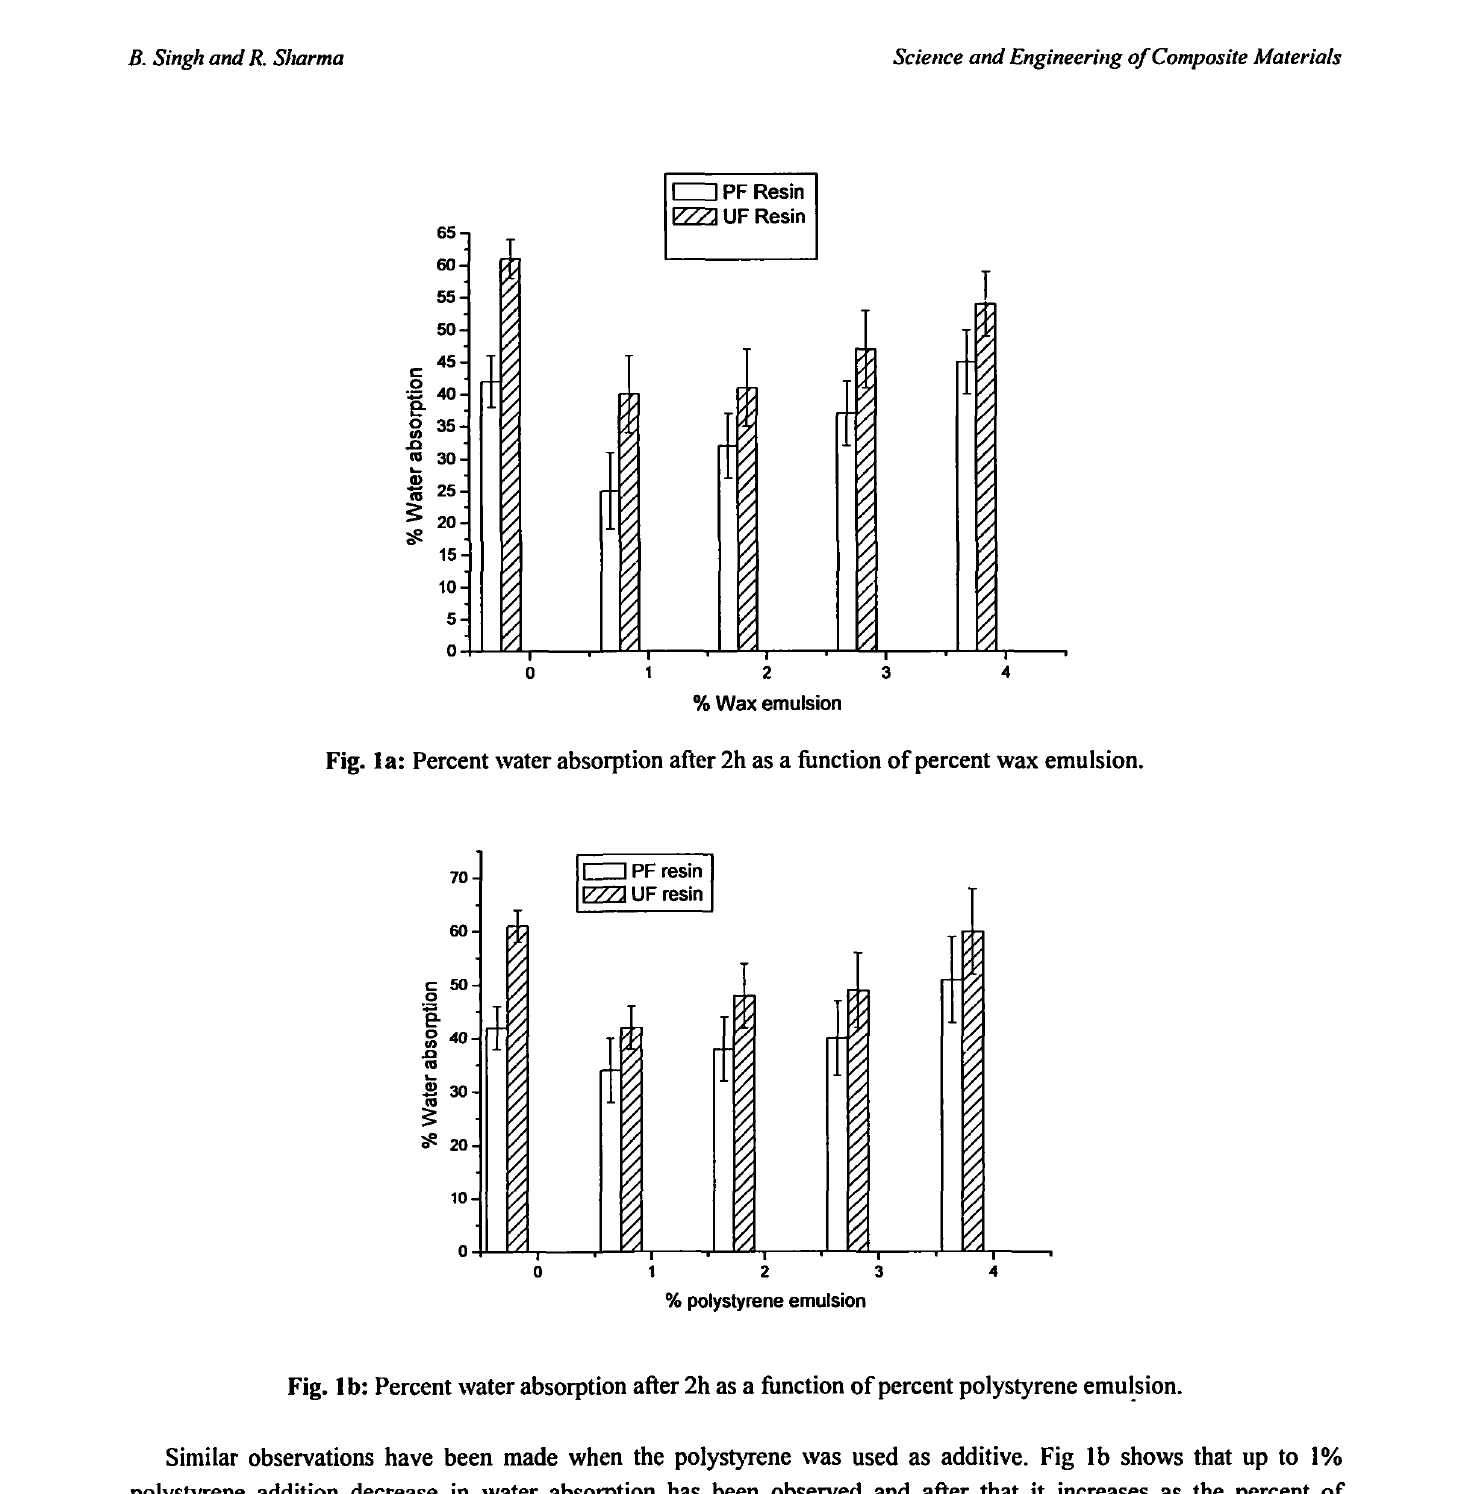
Fig. Ib: Percent water absorption after 2h as a function of percent polystyrene